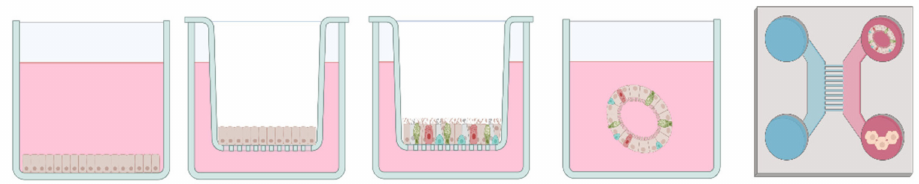
Figure 2. Biological models and approaches to studying in vitro toxicity of microbial volatile or- ganic substances (mVOCs). From left to right: Submerged system, single-cell air-liquid interface (ALI), multi-cell air-liquid interface (ALI), organoids and multi-organ chip approach, Created with BioRender.com, accessed on 20 August